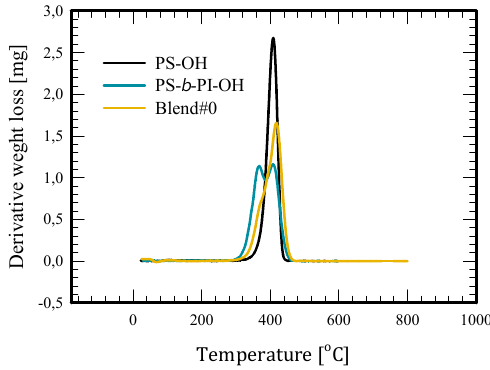
Figure 16. Di ff erential Thermogravimetry (DTG) plots of the samples PS-OH, PS- b -PI-OH, and Figure 16. Differential Thermogravimetry (DTG) plots of the samples PS ‐ OH, PS ‐ b ‐ PI ‐ OH, and Blend#0.